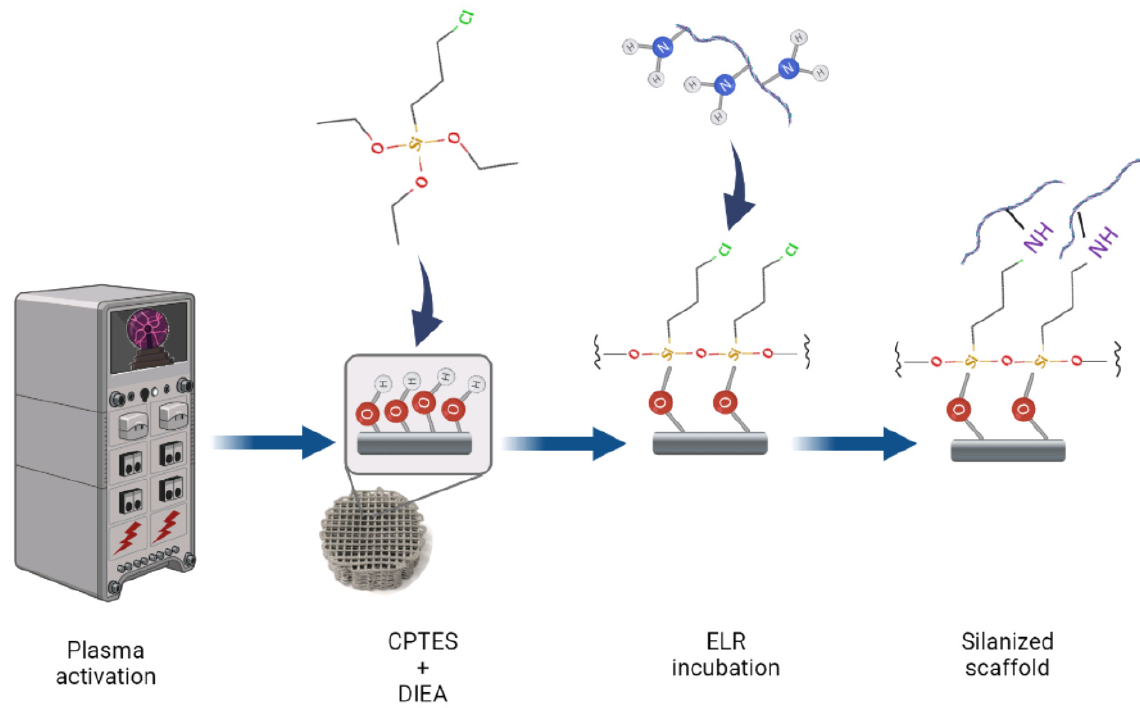
Figure 2. Schematic diagram of the functionalization